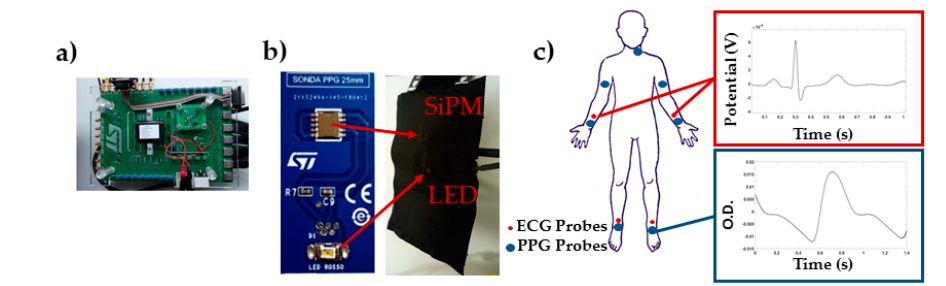
Figure 1. ( a ) Printed circuit board for data acquisition; ( b ) Example of PPG probe; ( c ) Placement of the PPG probes and ECG electrodes, and example of average single location, single pulse ECG and